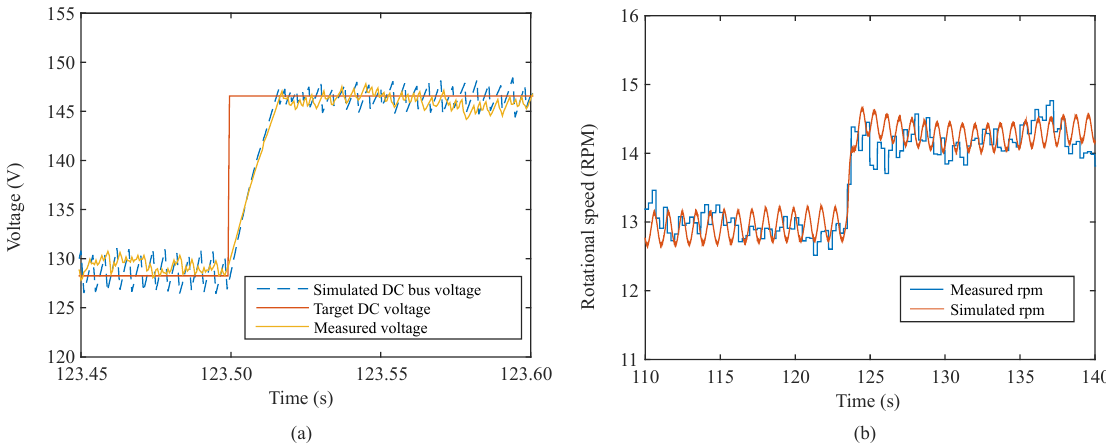
Figure 9. Simulated and experimental step response of turbine operation close to λ opt , with a step corresponding to an increase of λ : ( a ) DC bus voltage; ( b ) Rotational speed of the turbine.